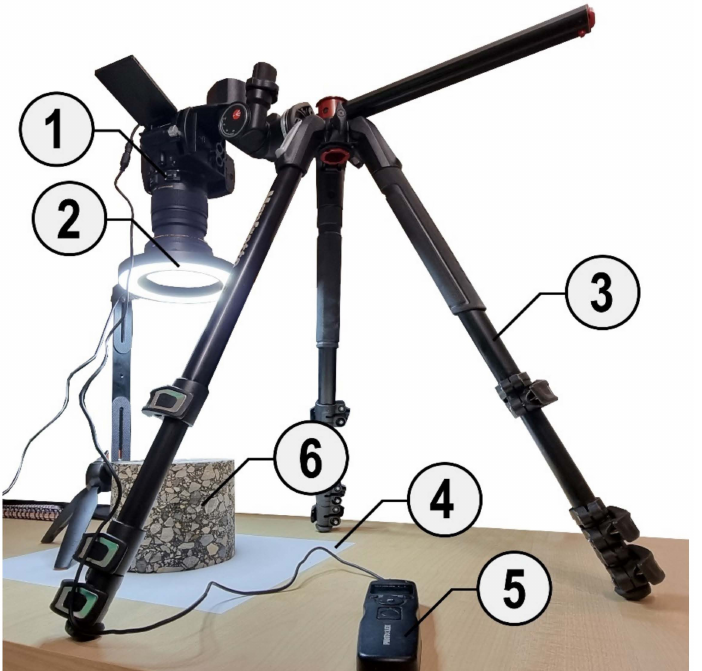
Figure 2. Test stand with DSLR camera (1), light source (2), tripod (3), uniform background (4), intervalometer (5) and tested specimen